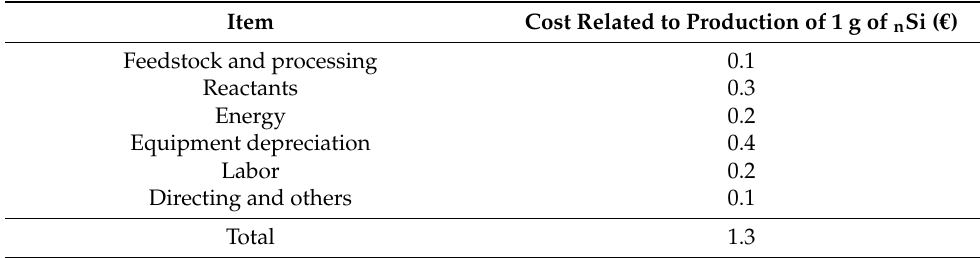
Table 2. Cost breakdown of the n Si production.